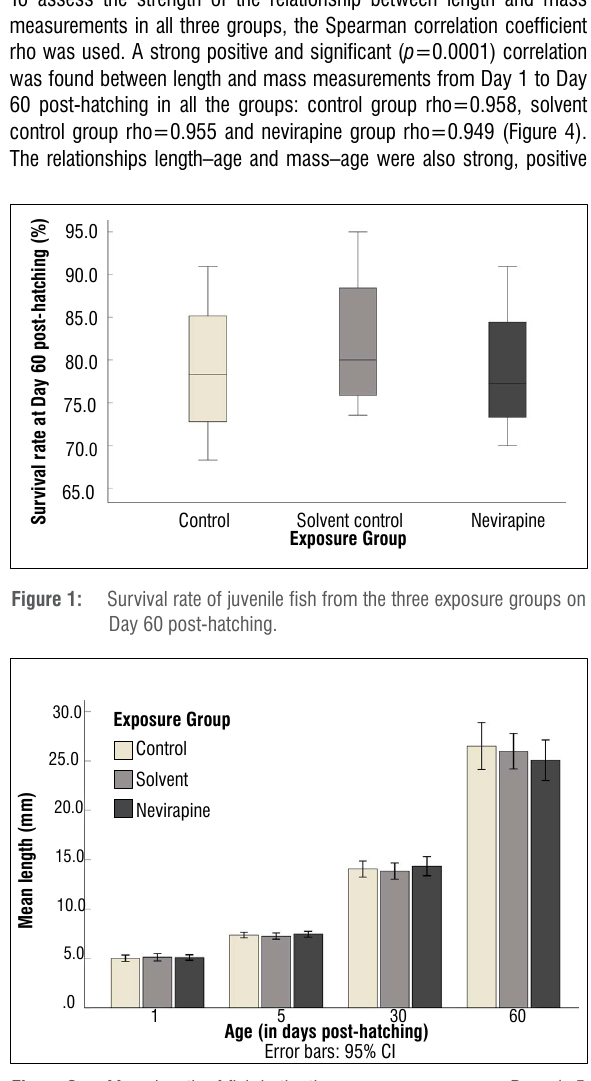
Figure 2: Mean length of fish in the three exposure groups on Days 1, 5, 30 and 60 post-hatching.